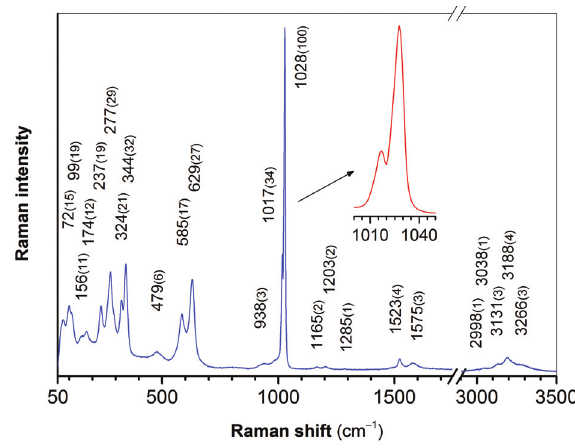
] with values of OH) [ VOF 3 4